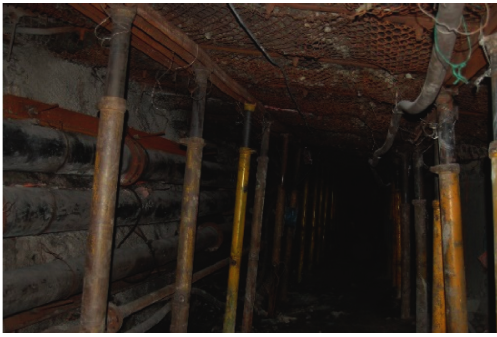
Figure 10: Roadway at 160 m after working